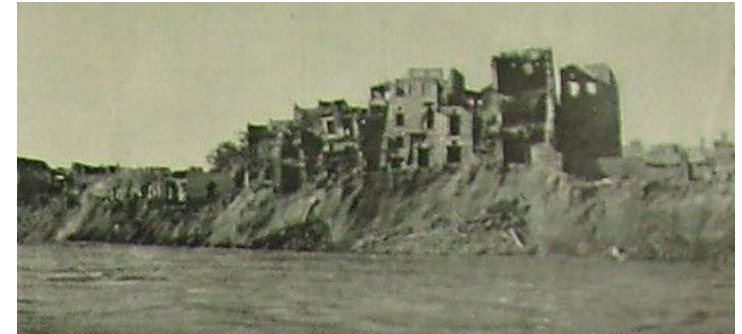
Figure 4. Image of DG Khan in process of abandonment in 1910 [44].